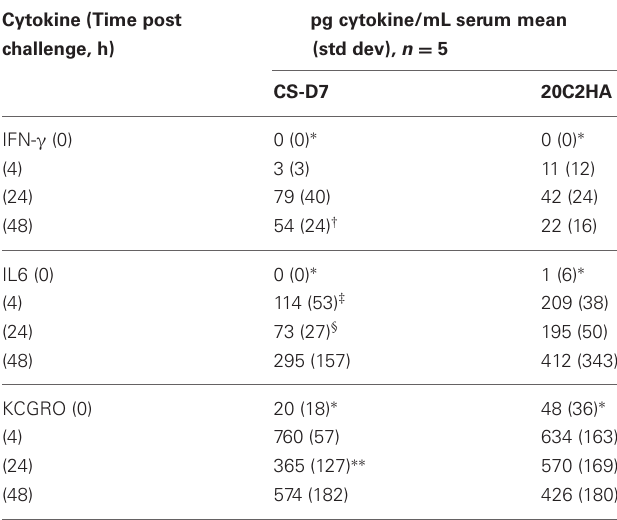
Table 7 | Serum cytokine levels after passive immunization with one of two mAbs and challenge with S. aureus